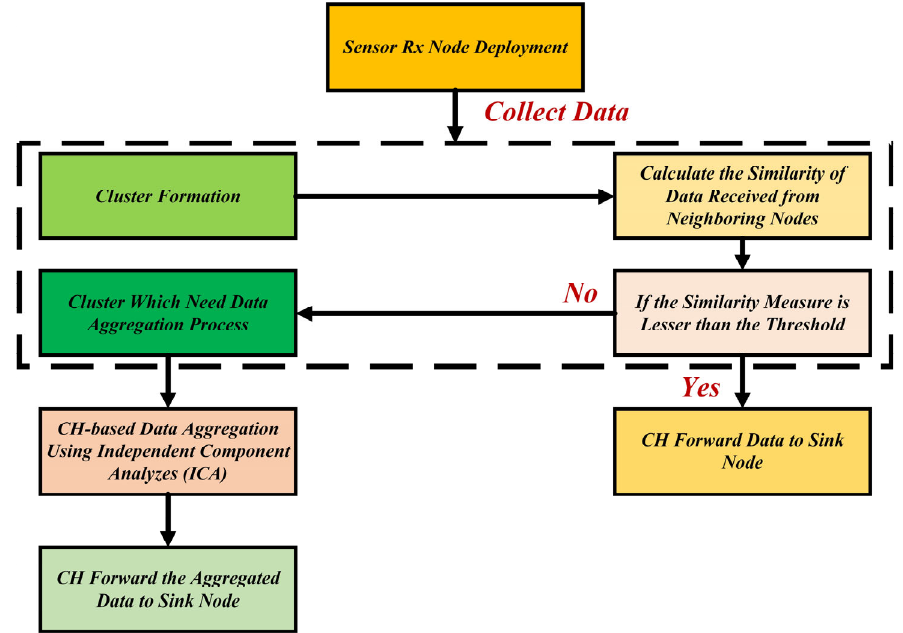
Figure 6. Flow diagram of data aggregation method [75] .